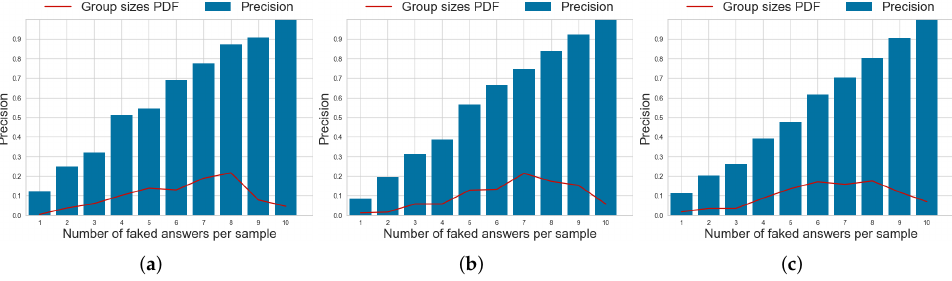
Figure 7. Probability density function (PDF) of the number of faked responses per questionnaire and per-item precision for the faking detection task using the SABA model on different datasets.